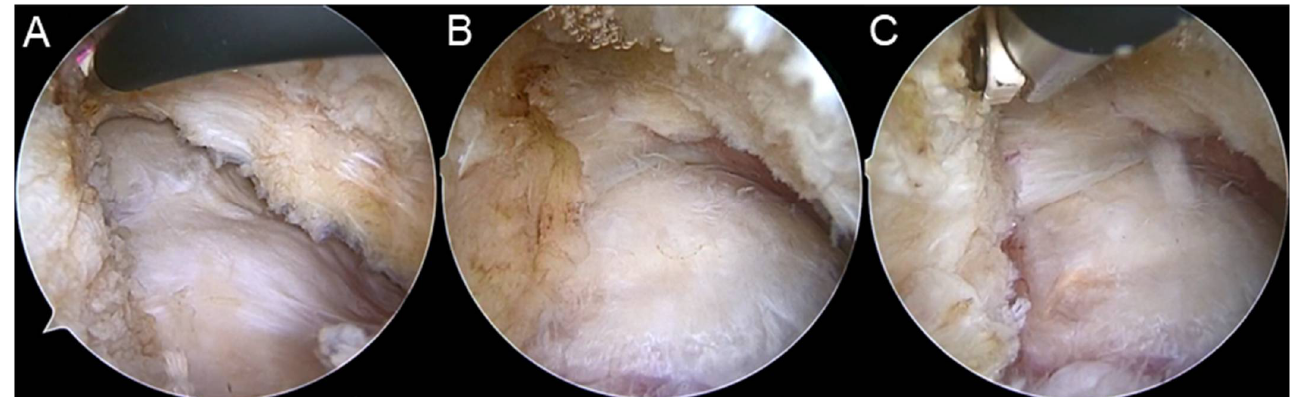
Figure 1. The procedures of modified longitudinal capsulotomy. ( A ) After the longitudinal capsulotomy was performed using radiofrequency probes, the arthroscopy was entered the hip joint and the femoral head–neck junction was exposed. ( B ) The longitudinal incision was extended proximally until the acetabular labrum was exposed. ( C ) A 1 cm transverse incision vertical to the longitudinal capsulotomy was performed in the proximal end of longitudinal incision.